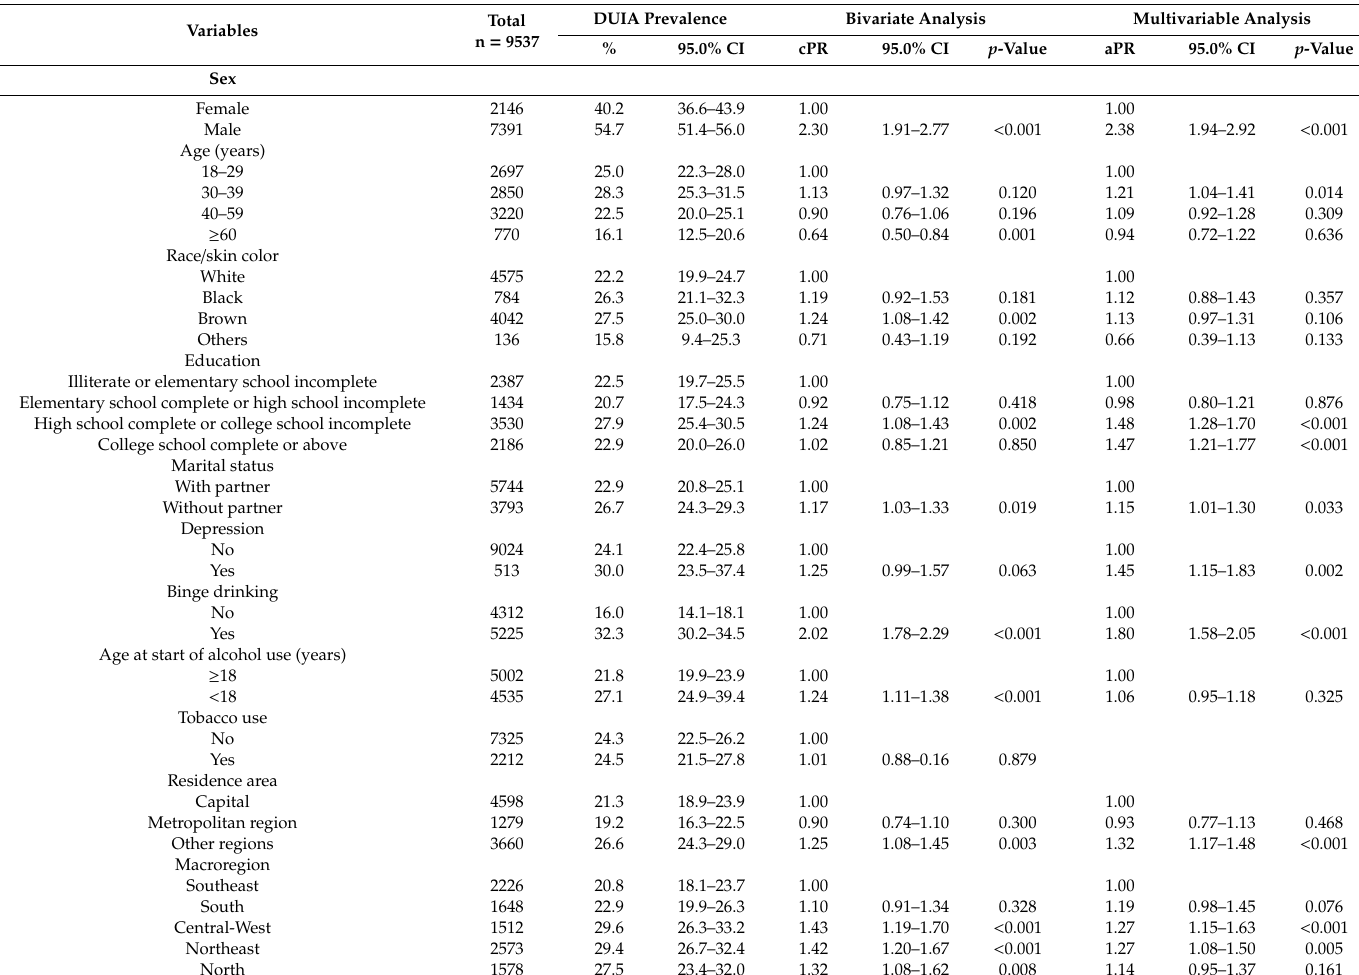
Table 1. Prevalence and Factors Associated with Driving Under the Influence of Alcohol in Brazil. National Health Survey,